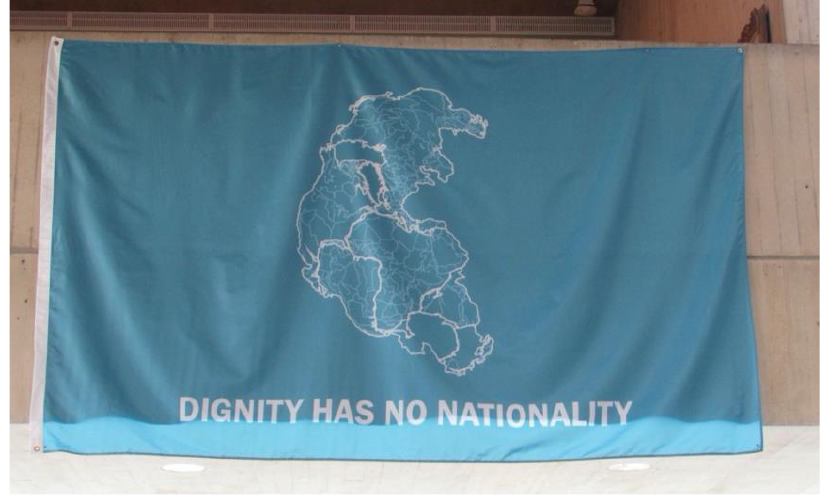
Figure 3 Tania Bruguera, Dignity has no nationality (2017). Nylon (Photo: